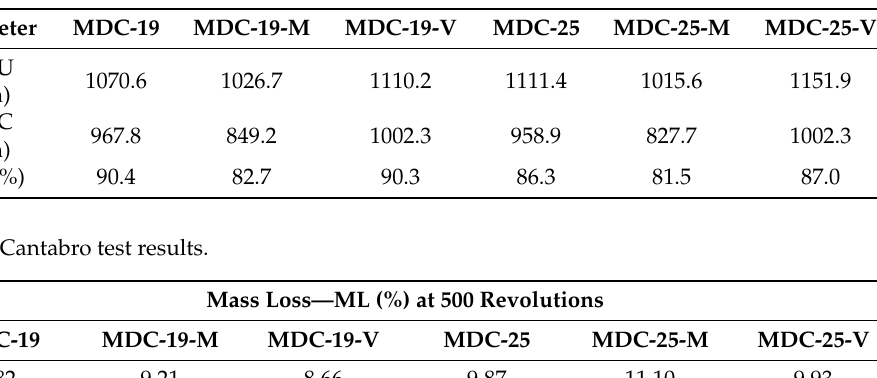
Table 5. Indirect tensile strength (ITS) test results.